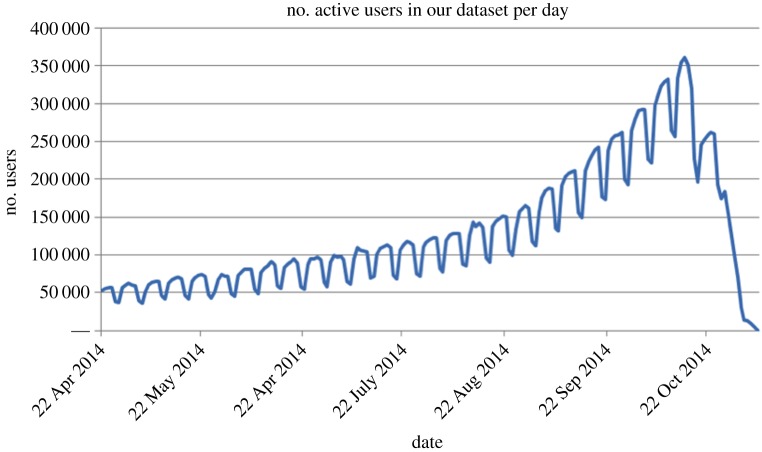
Number of active users per day. Dates before 22 April 2014 have fewer than 53 000 active users.